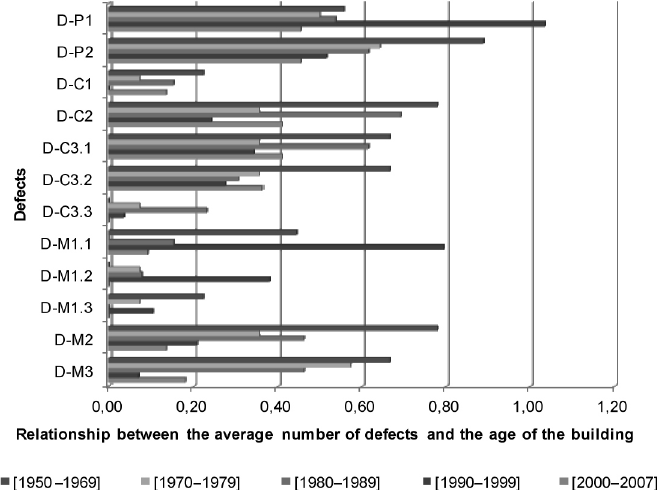
Fig. 5. Relationship between the average number of defects of each type and the age of the